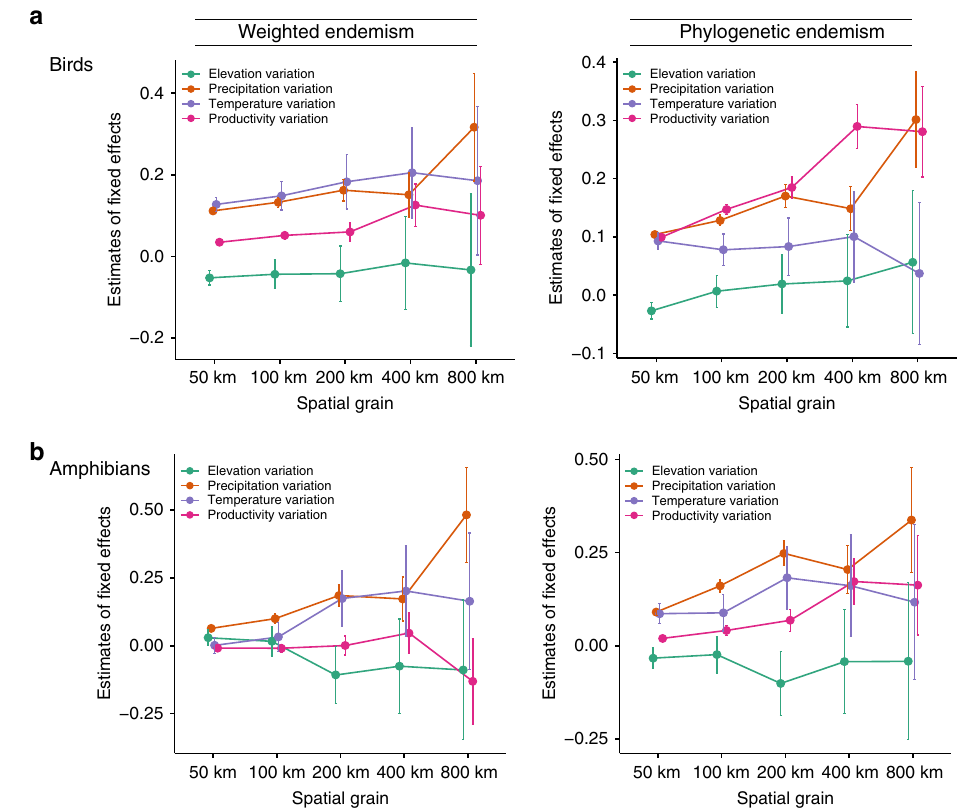
Fig. 4 The estimates and 95% con fi dence intervals for the fi xed effects predicted by a single linear mixed-effects model of endemism with all predictors (temperature variation, precipitation variation, productivity variation, elevation variation, spatial autocovariate and random effects of continent identities for each grid cell) across grain sizes. a Birds and b amphibians. These models indicate that our fi ndings are explained by environmental heterogeneity at coarser grains and to a lesser extent at fi ner resolutions (see Supplementary Tables 1 – 4). Signi fi cance was assessed by comparing likelihoods of the fi tted objects. Source data are provided as a Source Data fi